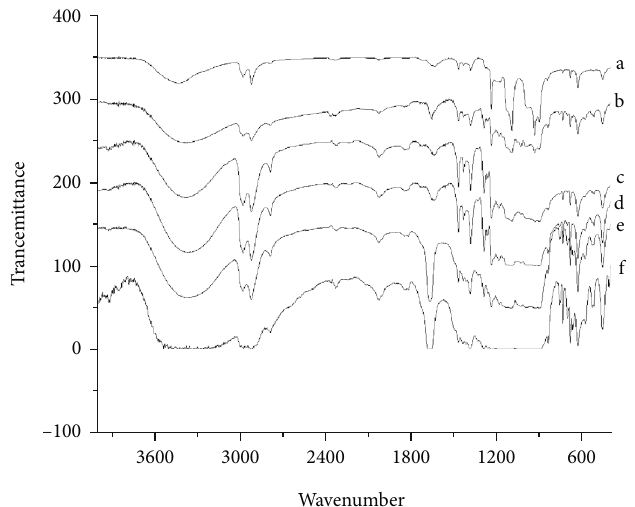
Figure 2: FTIR spectrum of POM/ β -CD micro fi bers fi lm with di ff erent content of β -CDs (a) 0wt.% β -CDs, (b) 10 wt.% β -CDs, (c) 20wt.% β -CDs, (d) 30 wt.% β -CDs, (e) 40wt.% β -CDs, and (f) 50wt.% β